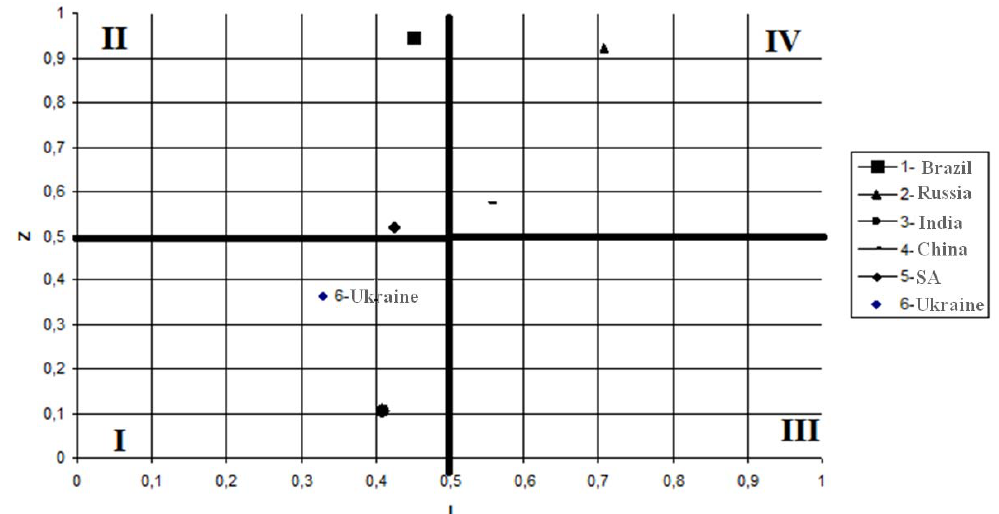
Fig. 2. Strategic positioning of Ukraine and member countries of BRICS in the first year of